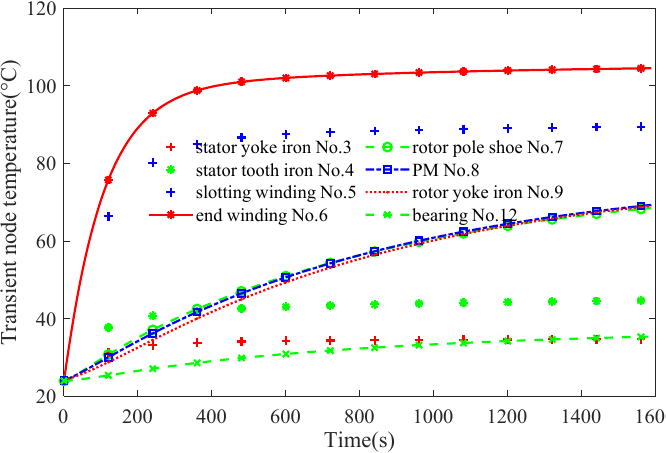
Figure 9. Transient temperature curve of different parts considering constant load. First-order, second-order, and third-order exponential decay functions are used to predict the transient winding temperature for two operating points, which are given as